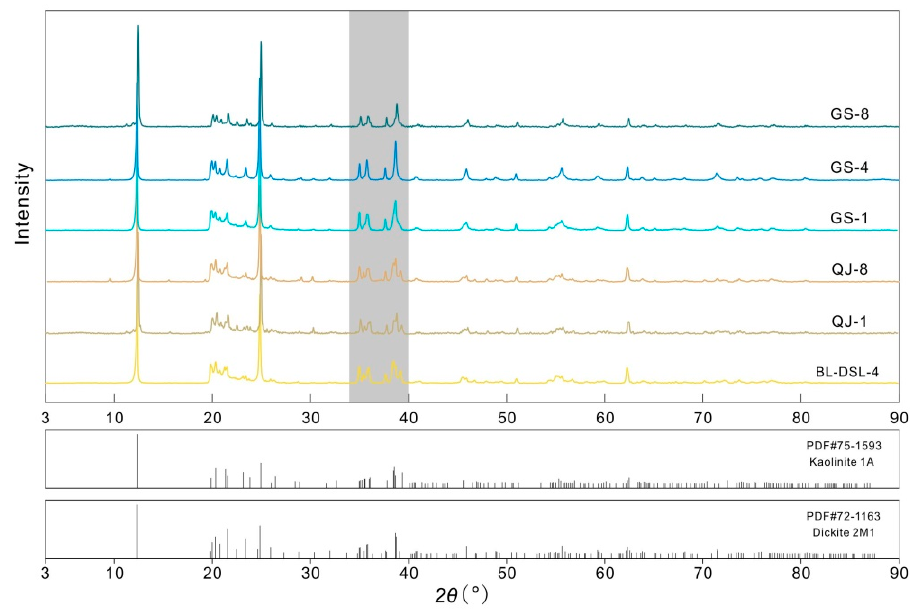
Figure 1. Powder XRD patterns of the samples.